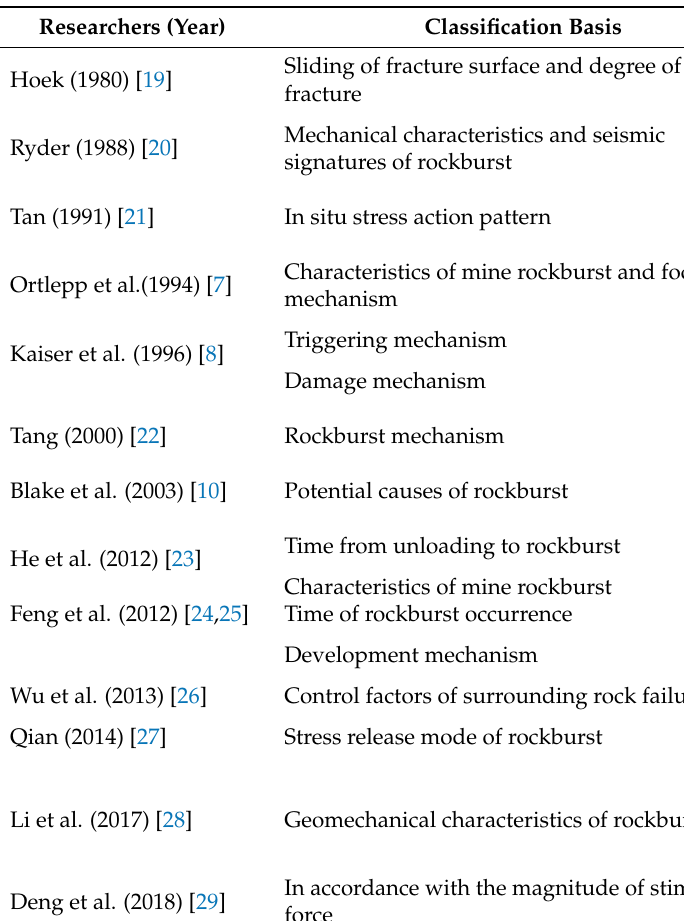
Table 2. Types of